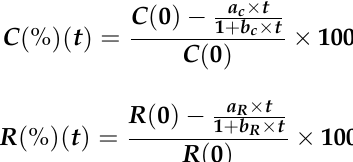
Table 1. Identified parameters of the Langmuir model at 60 °C and 70 °C.